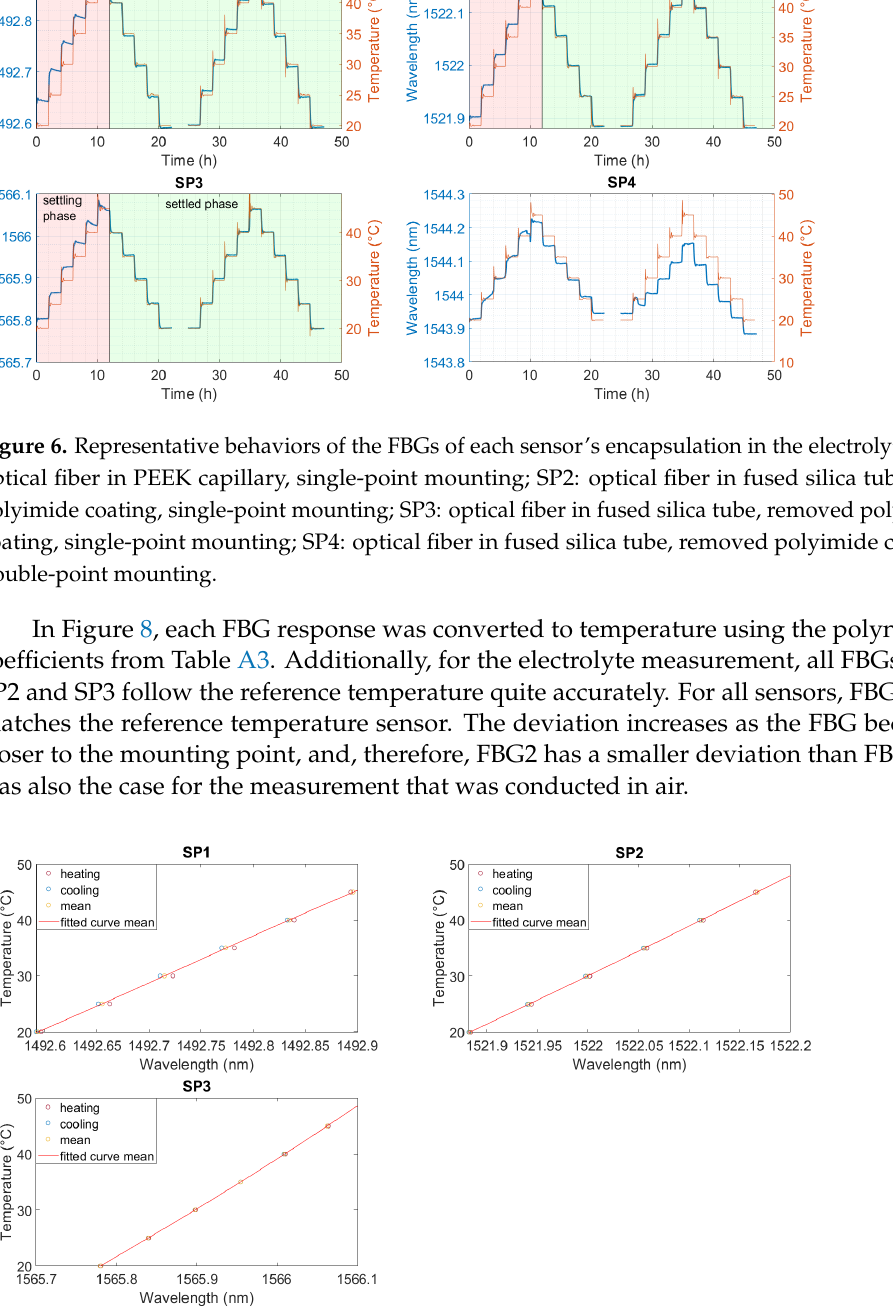
Figure 7. Calibration curve for the measurement in electrolyte for FBG3 for each sensor. Polynomial fit. SP1: optical fiber in PEEK capillary, single-point mounting; SP2: optical fiber in fused silica tube with polyimide coating, single-point mounting; SP3: optical fiber in fused silica tube, removed polyimide coating, single-point mounting; SP4: optical fiber in fused silica tube, removed polyimide coating, double-point